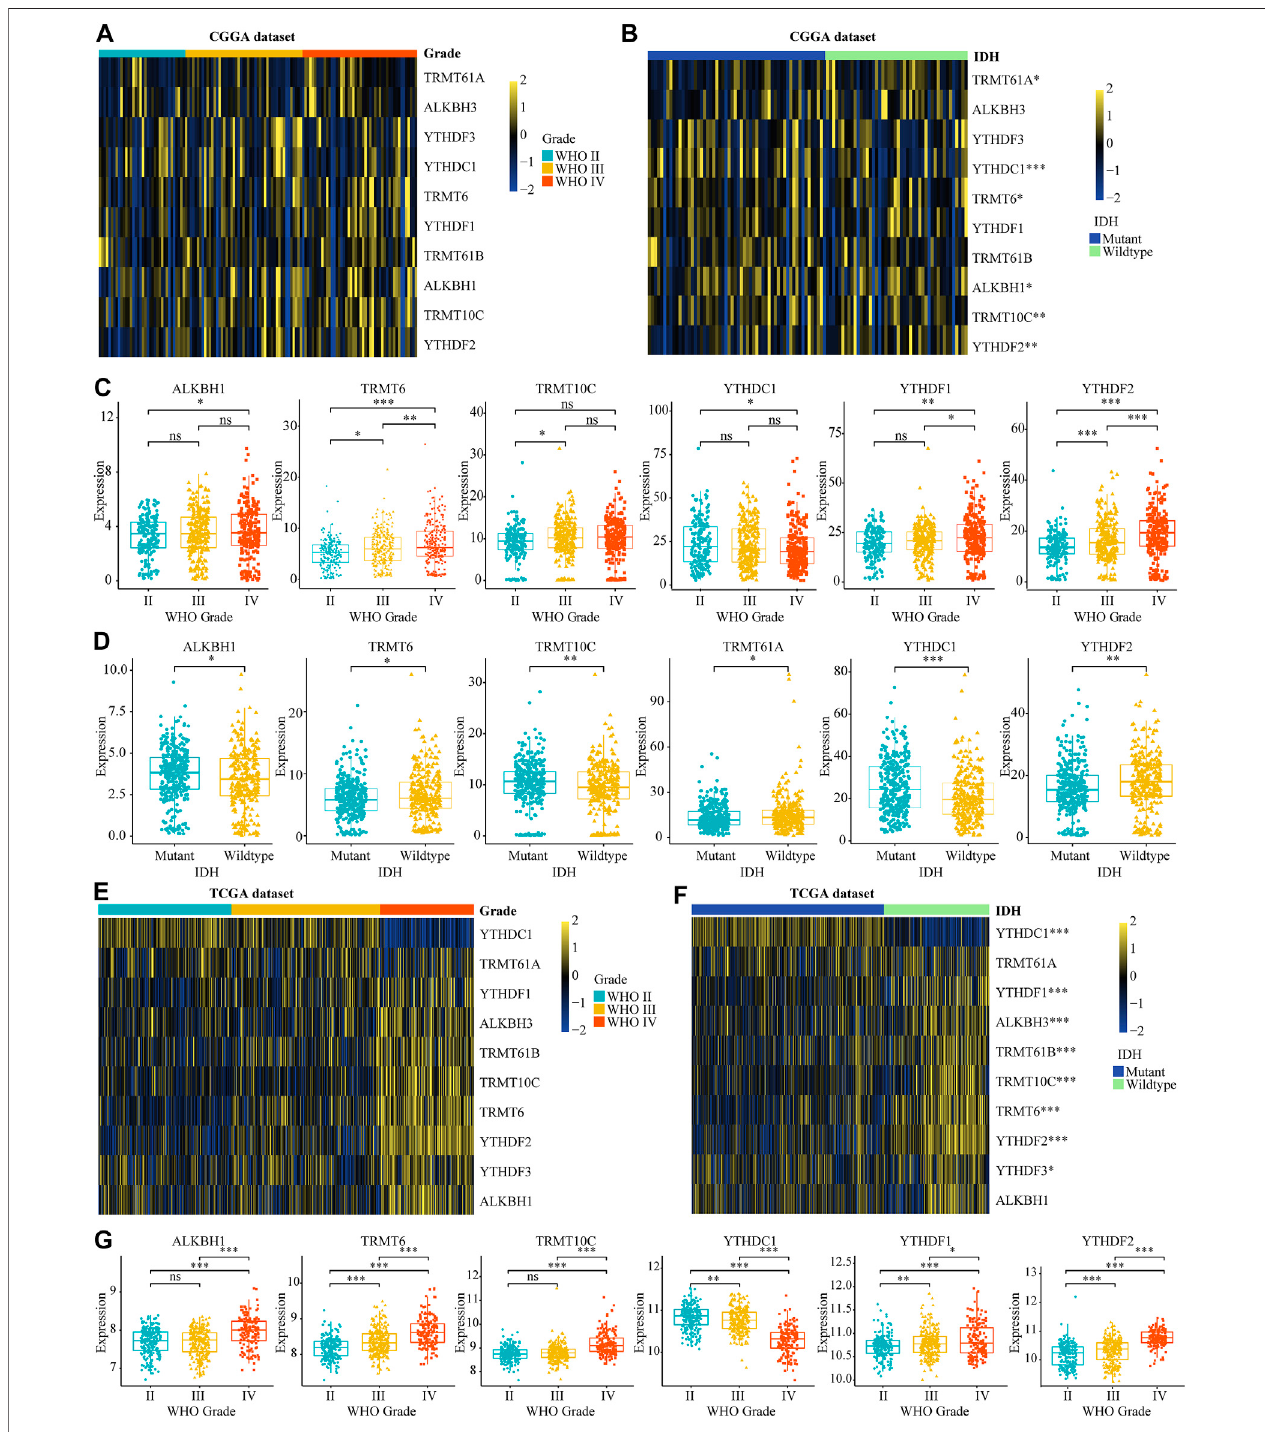
FIGURE 1 | Relationship between the variation of m5C regulators and clinical features in glioma. (A, B) The differential expression of m1A regulators with different WHO grades and IDH mutation statuses in CGGA dataset. (C, D) The signi fi cant differential expression m1A regulators strati fi ed by WHO grade and IDH mutation statuses in CGGA dataset. (E, G) The differential expression of m1A regulators strati fi ed by WHO grade and IDH mutation statuses in glioma according to TCGA database. * p < 0.05, ** p < 0.01, *** p < 0.001.